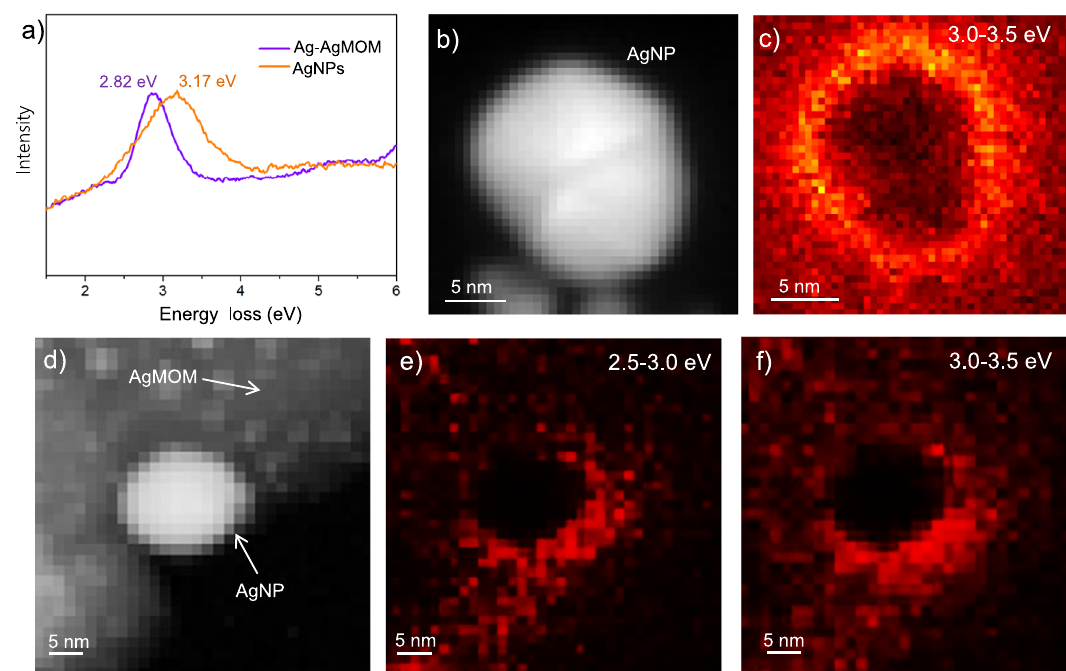
Fig. 4 | Low-loss EELS and HAADF-STEM characterizations of AgNPs and Ag – AgMOM. a Background-subtracted (zero-loss tail removed) EELS spectra. b HAADF-STEMimageofAgNPand c PlasmonmappingofAgNPintheenergyrange